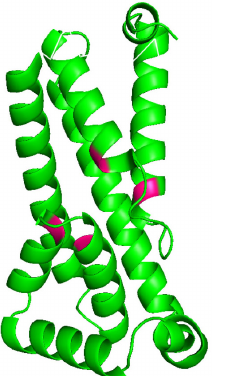
Figure 8. Essential residues determined by SDM experiments highlighted in pink on a truncated YqjA